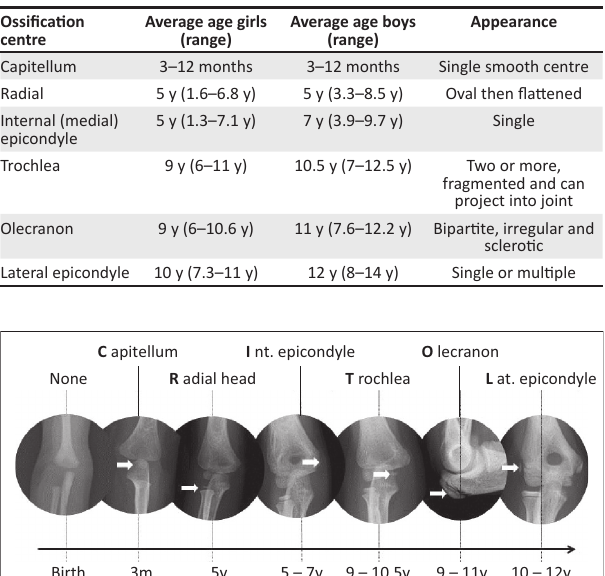
TABLE 1: Ossification centres. 13,14,15